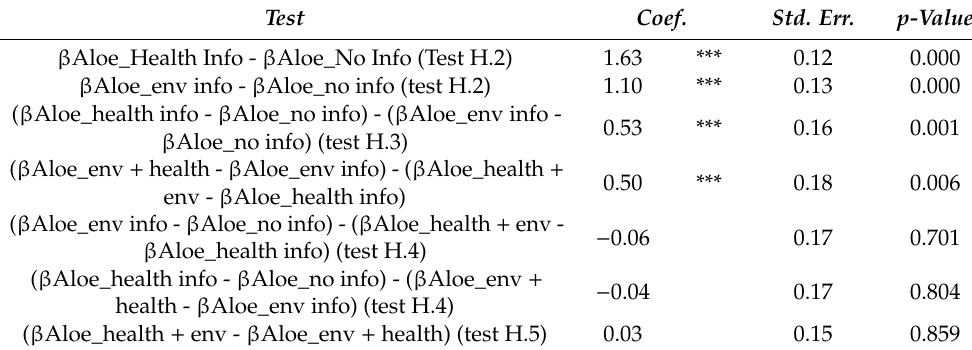
Table 5. Hypothesis testing on the statistical di ff erence among Model 2 regression coe ffi cients β . Test Coef. Std. Err.